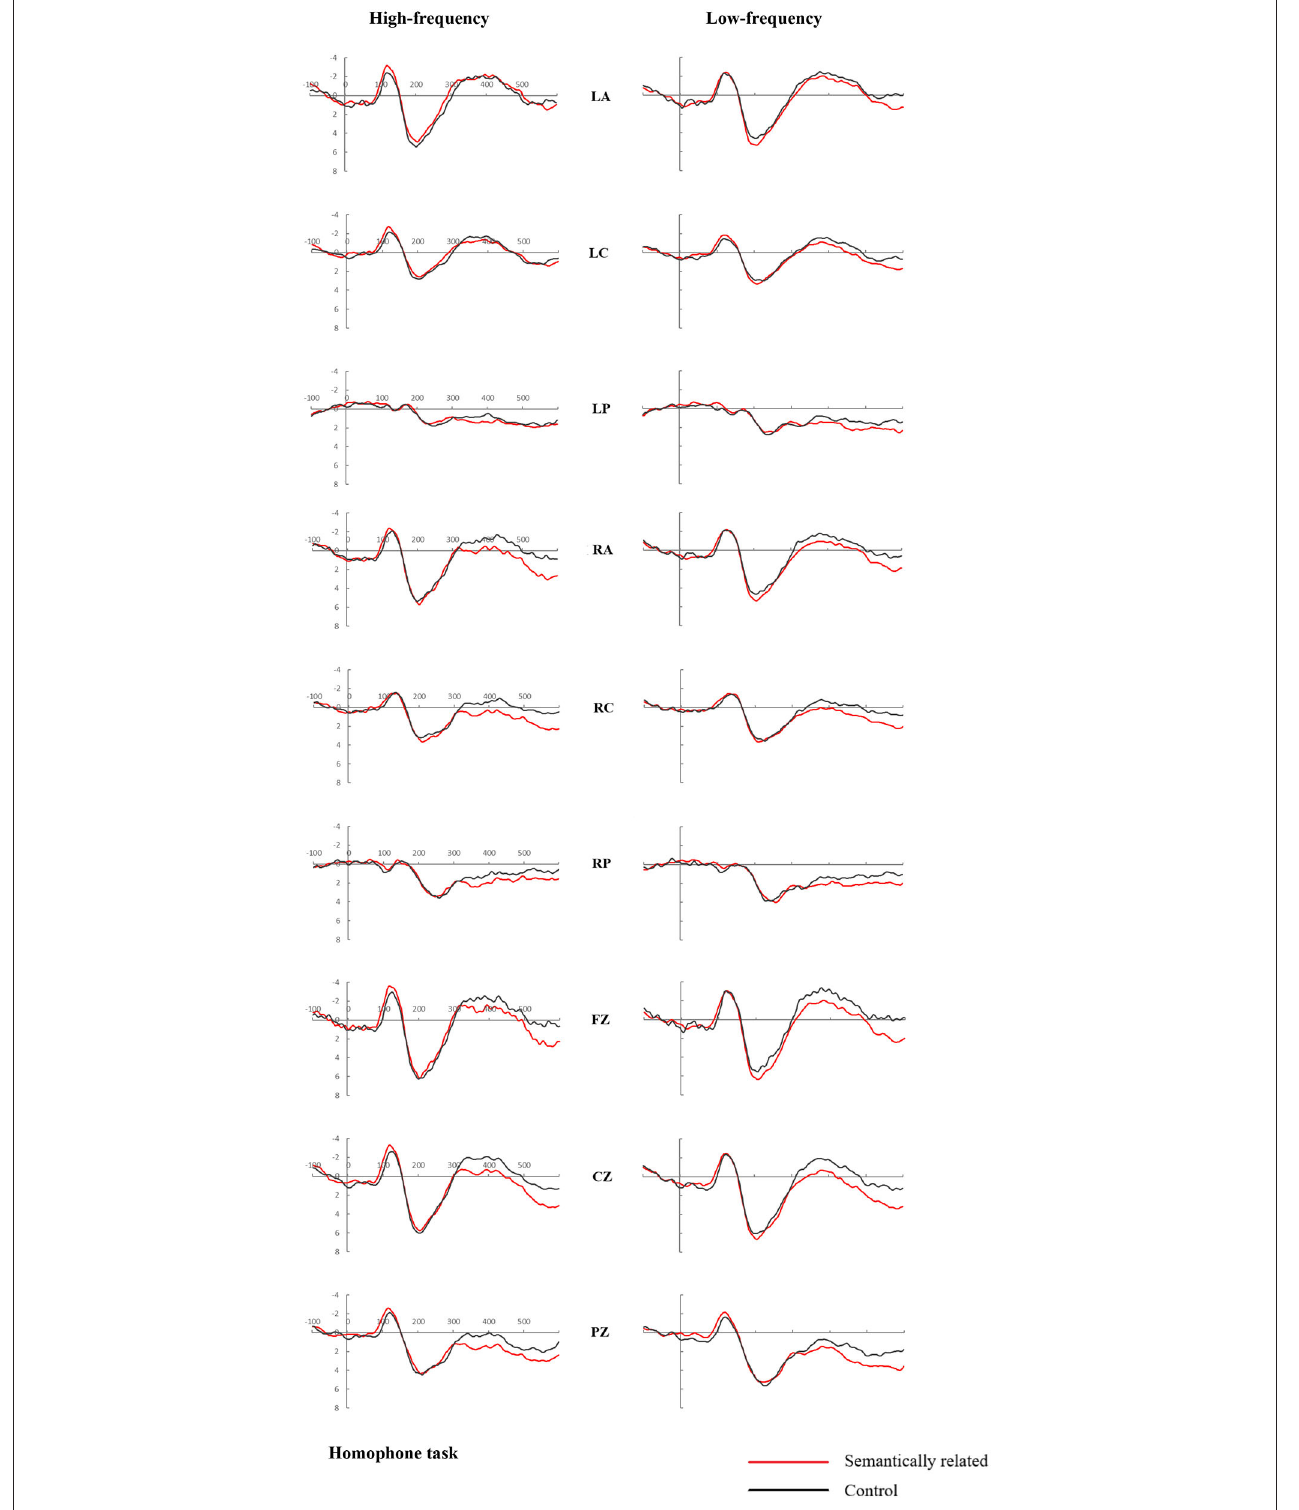
FIGURE 4 | Grand mean event-related potentials in response to target words, from representative electrodes (LA, LC, LP, RA, RC, RP, Fz, Cz, and Pz), for the semantically related and control pairs in the homophone task.